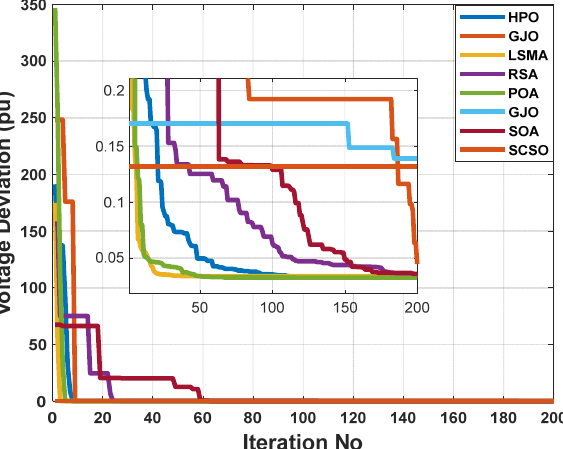
Figure 9. The convergence characteristics of POA and other compared algorithms for case 3 in a standard IEEE 14-bus test system.